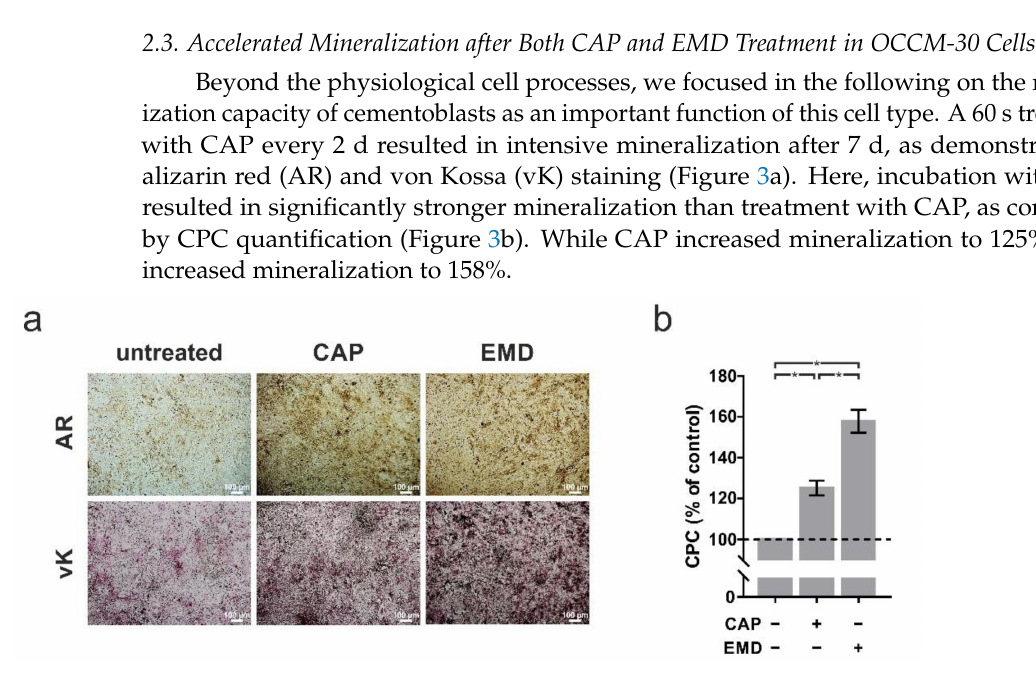
Figure 3. Effects of CAP and EMD application (100 µ g/mL) mineralization in OCCM-30 cells (+) as compared to untreated cells ( − ). ( a ) Alizarin Red (AR) and von Kossa (vK) staining of OCCM-30 cells cultivated in medium for induction of mineralization at 7 days. The scale bars represent 100 µ m. ( b ) Spectrophotometric quantification of AR staining, using the CPC extraction method ( n = 9). * statistical significance ( p <